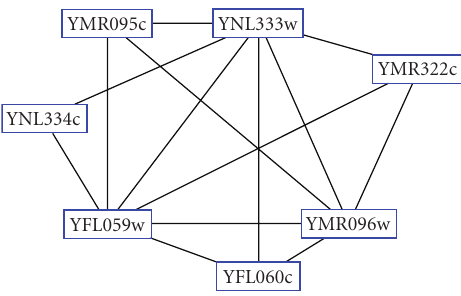
Figure 5: Group 93 identified as a near-clique by our